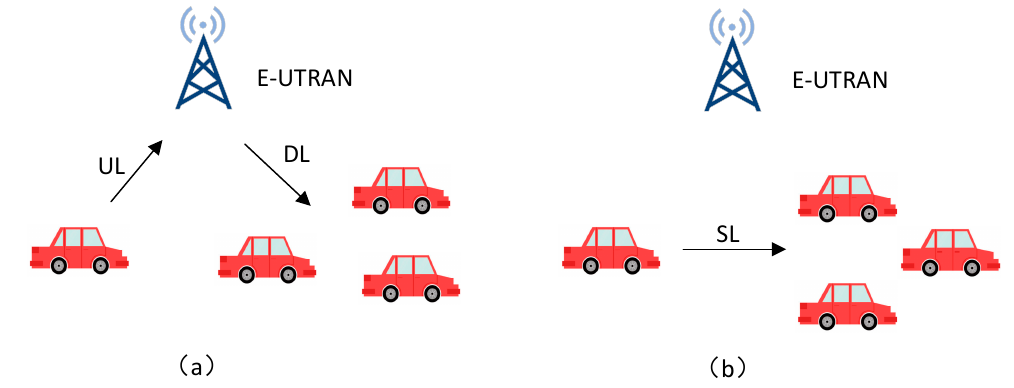
Figure 1. LTE-V2X Communication Modes. (a) Uu mode for LTE-V2X (b) PC5 mode for LTE-V2X